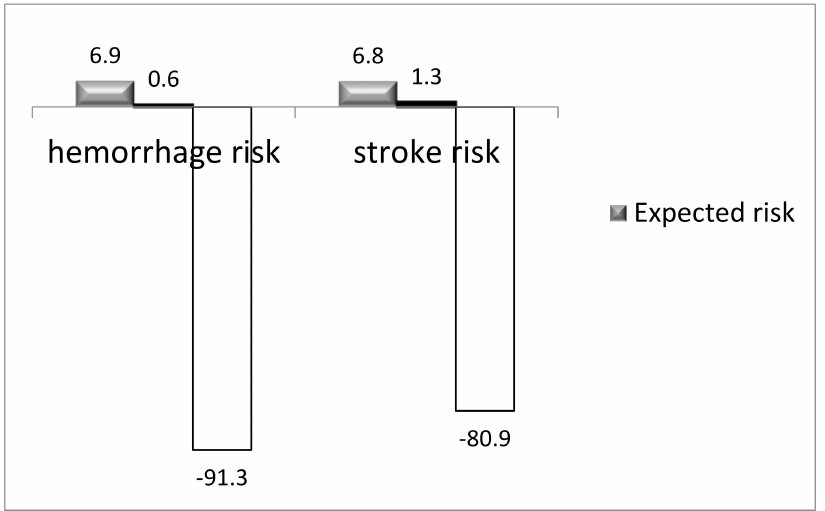
Figure 3. RR reduction for hemorrhage and stroke.